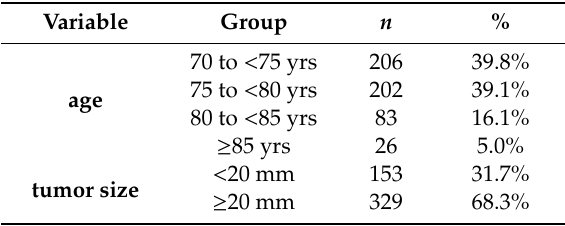
Table 1. Summary of patient characteristics ( n = 517).